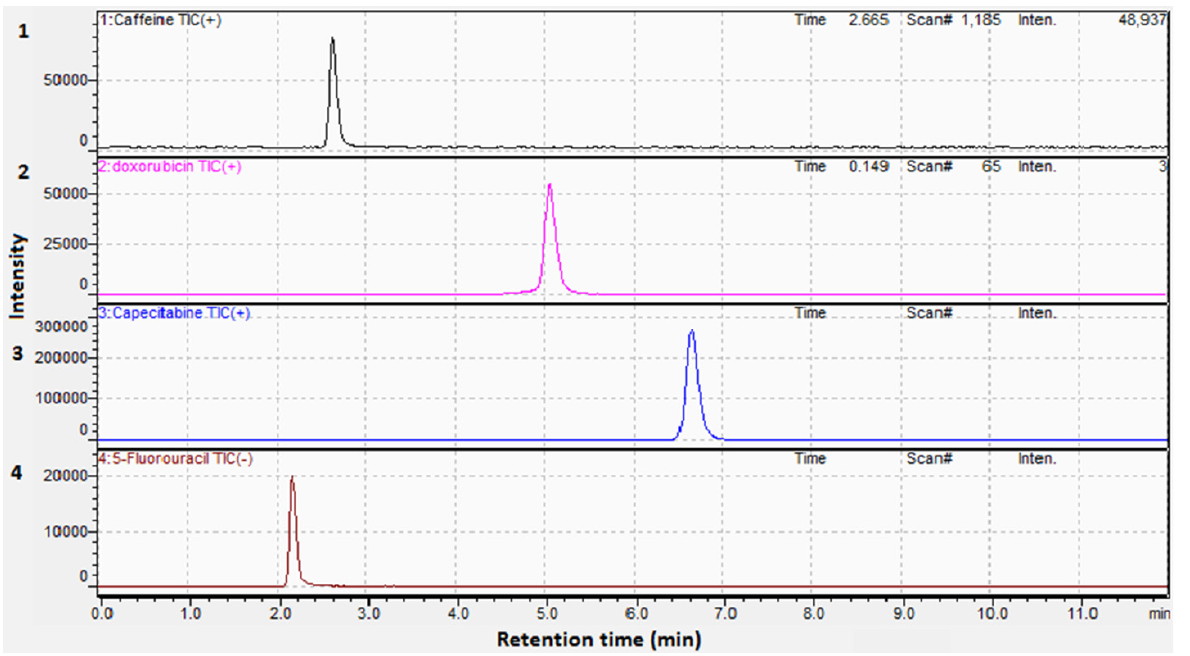
Figure 3. MRM chromatograms of ( 1 ). (50.00 ng/mL) Caffeine, ( 2 ). (100.00 ng/mL) Doxorubicin, ( 3 ). (20.00 ng/mL) Capecitabine, and ( 4 ). (200.00 ng/mL) 5-Fluorouracil.